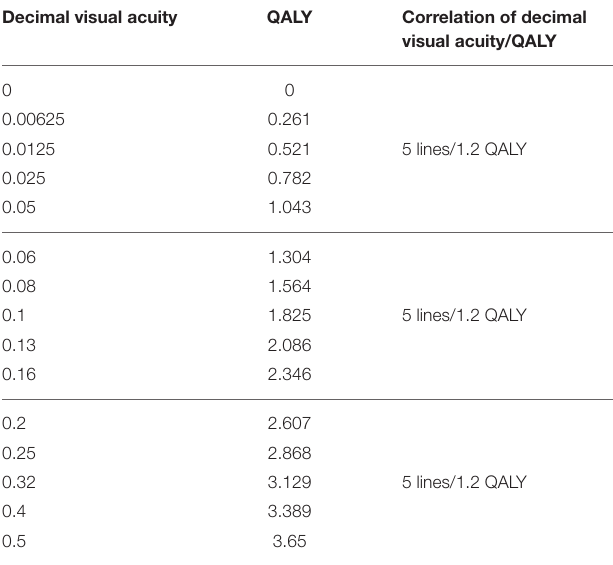
TABLE 2 | Correlation between decimal visual acuity and quality-adjusted life-years (QALY) gained by infants with good and poor visual functions. Decimal visual acuity